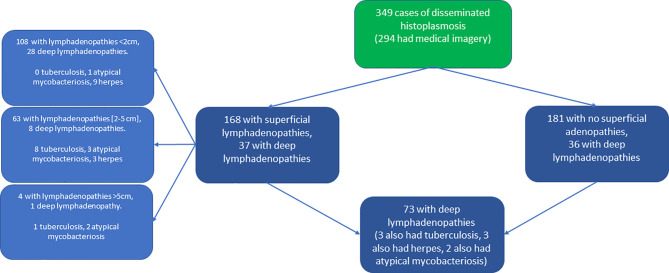
Flowchart stratifying patient counts by presence of superficial or deep lymphadenopathies.